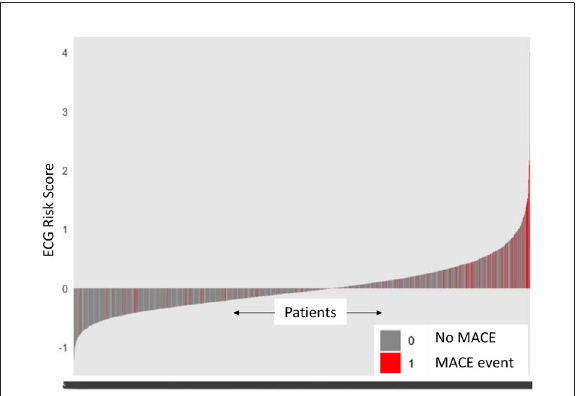
FIGURE2 ECG risk score predicts MACE events. Patients with higher ECG risk score (eRiS) correlate with occurrence of MACE events, demonstrating the value of considering ECG as a factor in determining probability of a MACE event. X-axis denotes patients arranged in ascending value of eRiS scores.